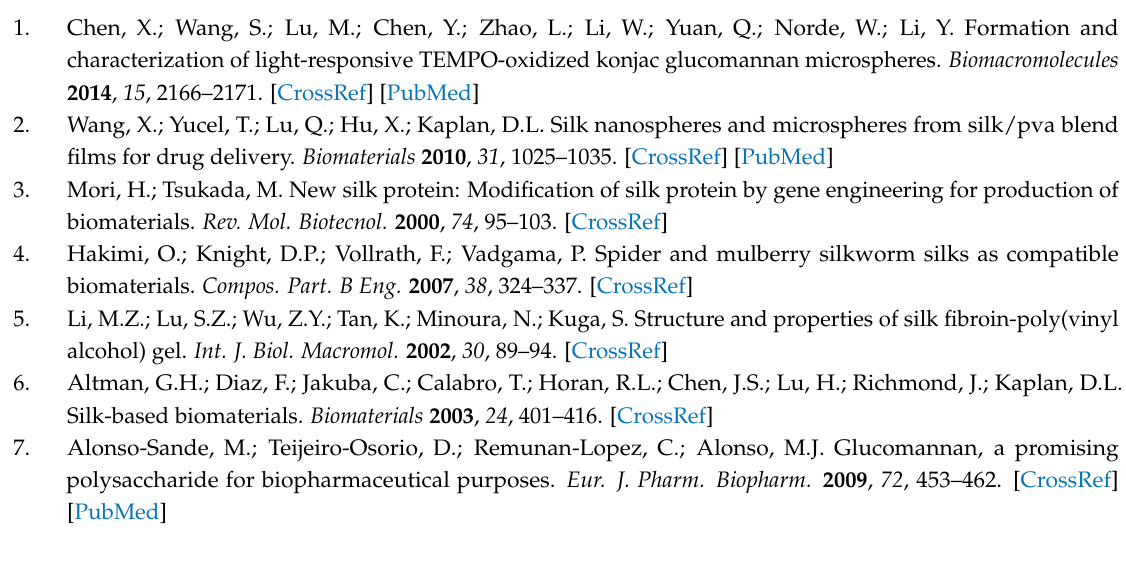
Figure S1: Deconvolution of FTIR-ATR spectra of SF/KGM beads treated with ethanol obtained at different ratios of SF and KGM ( v / v ), Table S1: β -sheet percent obtained from the deconvolution of FTIR-ATR spectra of SF/KGM beads treated with ethanol obtained at different ratios of SF and KGM ( v / v ) for the amide I, II and III. In red the percentage referring to the conformation β